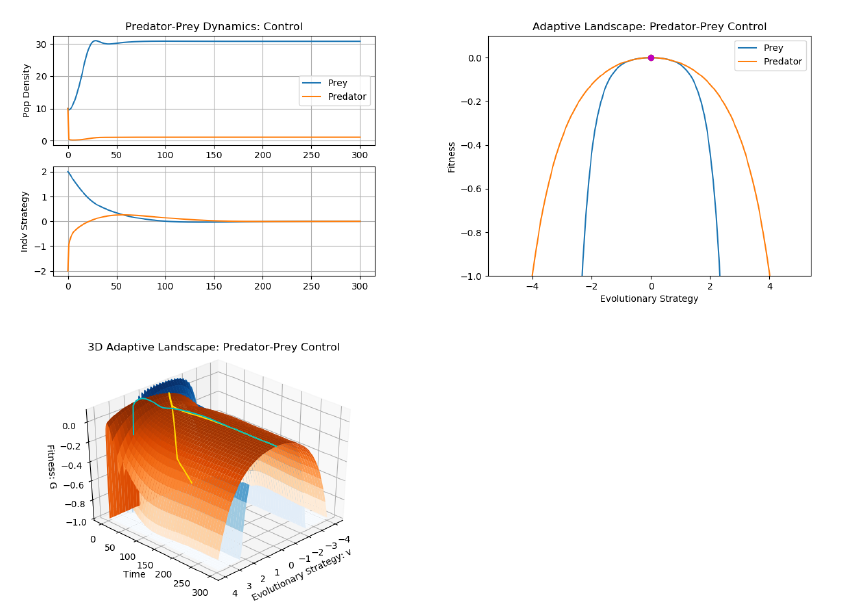
Figure 3. Predator–prey control simulations. The first panel depicts the population and strategy dynamics of predator (orange/gold) and prey (blue/cyan). The second panel is a snapshot of the adaptive landscape at the eco-evolutionary equilibrium. The third panel is a 3D adaptive landscape, showing the changes in the adaptive landscape over time. Note that the adaptive landscape stays relatively constant over time and the ESS for both prey and predator occur when their focal strategies are 0.